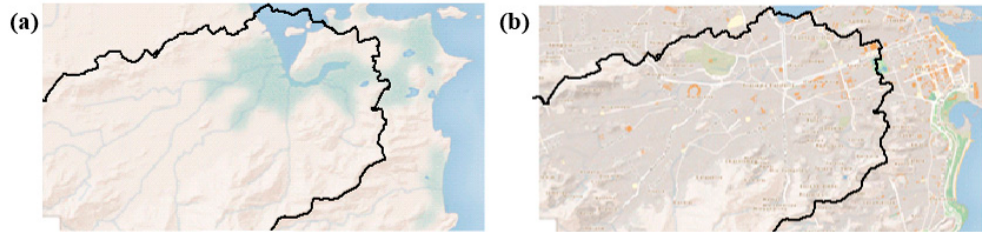
Figure 6. Canal do Mangue region: (a) Natural condition and (b) Present condition [38].